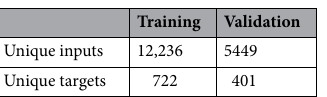
Table 1. Distribution of examples between the training and validation sets.